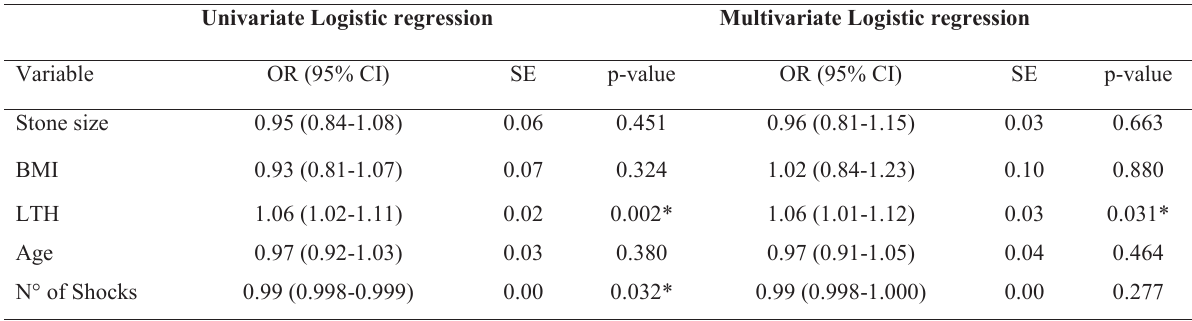
The Lithotripsy Table Height Table 2. Univariate and multivariate analysis of factors predicting residual fragments. Univariate Logistic regression Multivariate Logistic